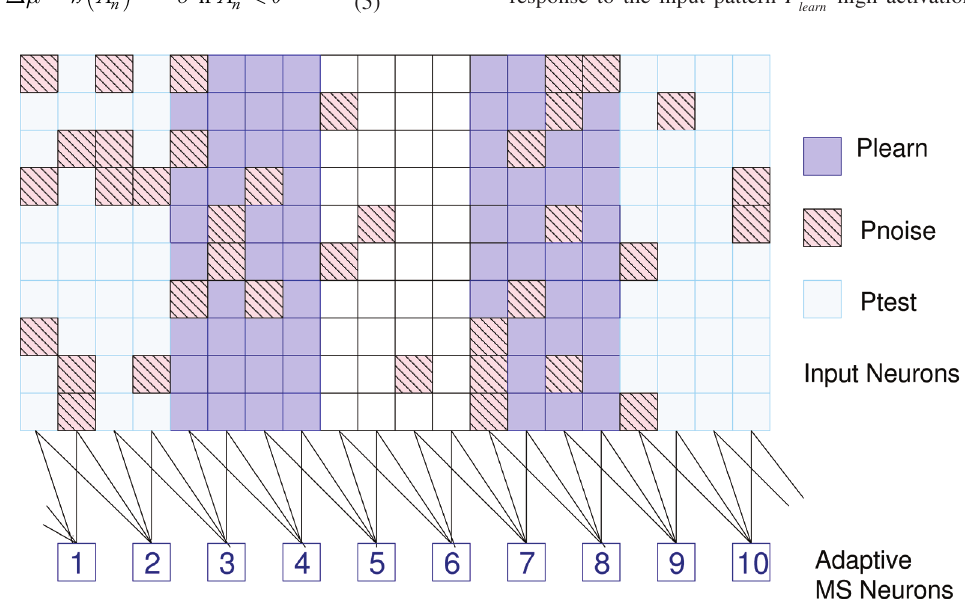
Figure 5. Pattern learning. 200 input neurons (arranged as 20 × 10), 10 learning neurons, and definitions for 3 patterns. Only 37 of 80 data points for P are noise